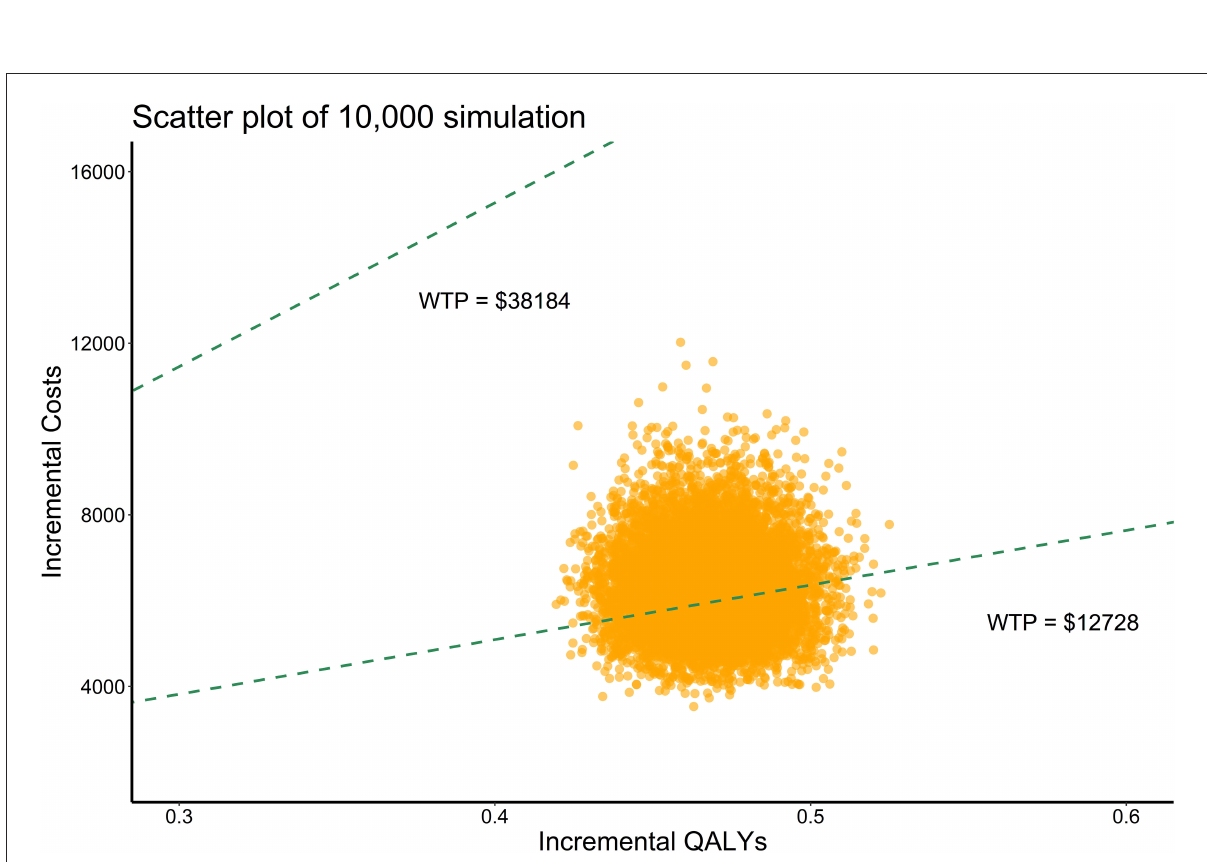
FIGURE2 Probabilistic sensitivity analysis, scatter plot (10,000 iterations). WTP, willingness-to-pay; QALYs, quality-adjusted life